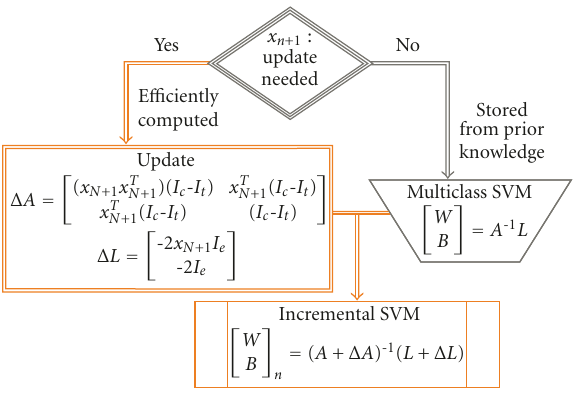
Figure 3: Process flow for the incremental model parameter up- dates.